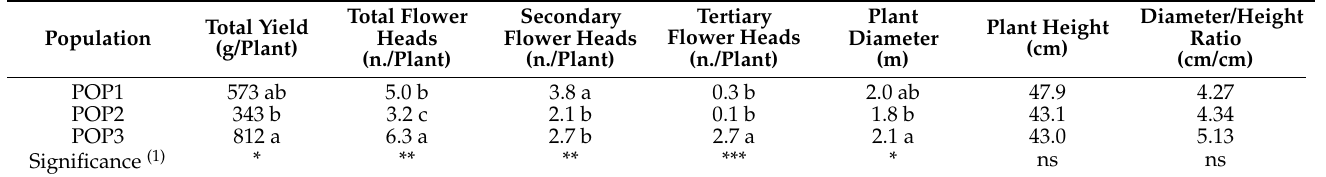
Table 2. Total production, total yield, total number of flower heads (secondary and tertiary), plant diameter, height and diameter/height ratio of three populations of ‘Carciofo di Lucera’ (1) .